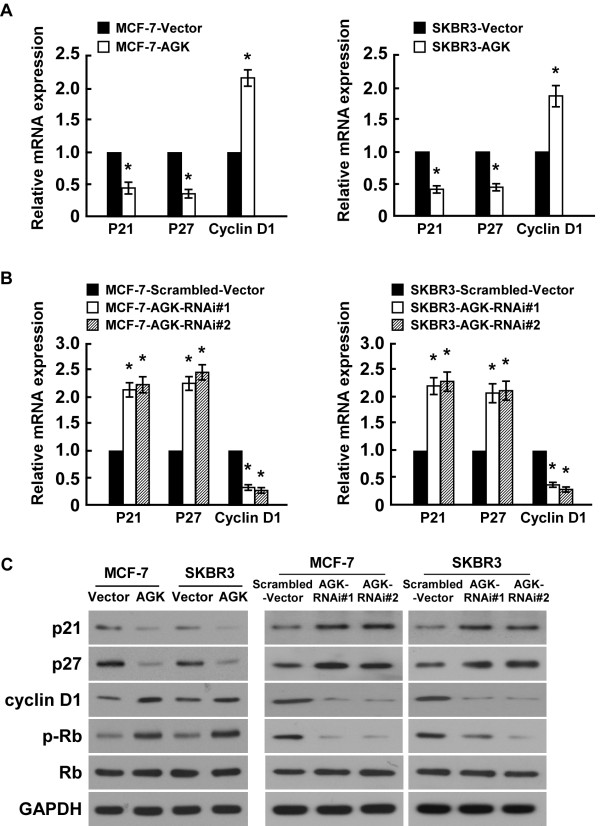
AGK alters expression in G1-S phase cell-cycle regulators. (A and B) Real-time PCR analysis of p21Cip1, p27Kip1 and cyclin D1 mRNA expression in AGK-infected cells (A) or AGK-shRNA infected cells (B). Gene expression levels were normalized to GAPDH. (C) Western blotting analysis of p21Cip1, p27Kip1, cyclin D1, p-Rb and total Rb protein expression in AGK-infected cells and AGK-shRNA infected cells; GAPDH was used as a loading control. Each bar represents the mean ± SD of three independent experiments. *P < 0.05.